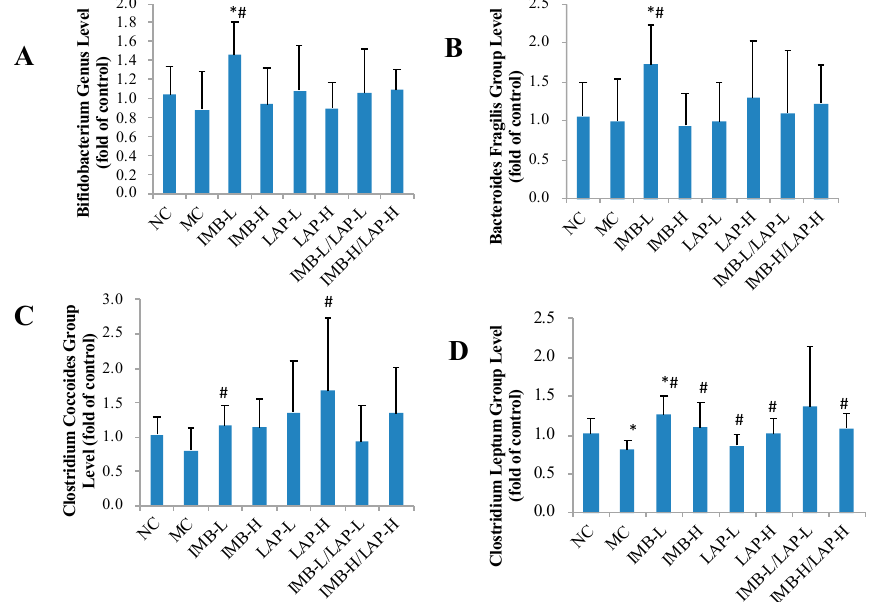
Figure 6. Effects of IMB and LAP supplements on gut microbiota levels. Bifidobacterium genus (A), Bacteroides fragilis group (B), Clostridium coccoides group (C), and Clostridium leptum group (D). Values are expressed as Mean±SD, n=8. Within each panel, values with the superscript symbols “*” and “#” are significantly different from the NC and MC, respectively, P at least <0.05.